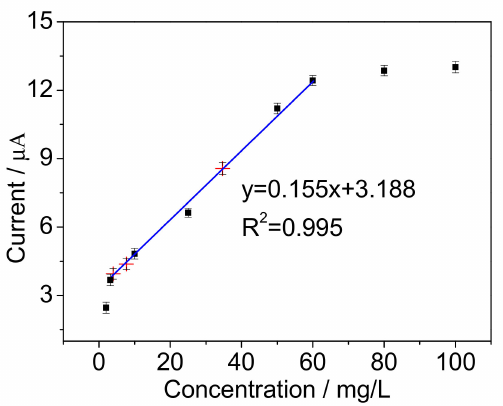
Figure 12. The calibration curve of the mediated BOD biosensor. The red intersection points “ × ” standards for BOD measurement of real water samples. The error bars represent three replicate measurements.